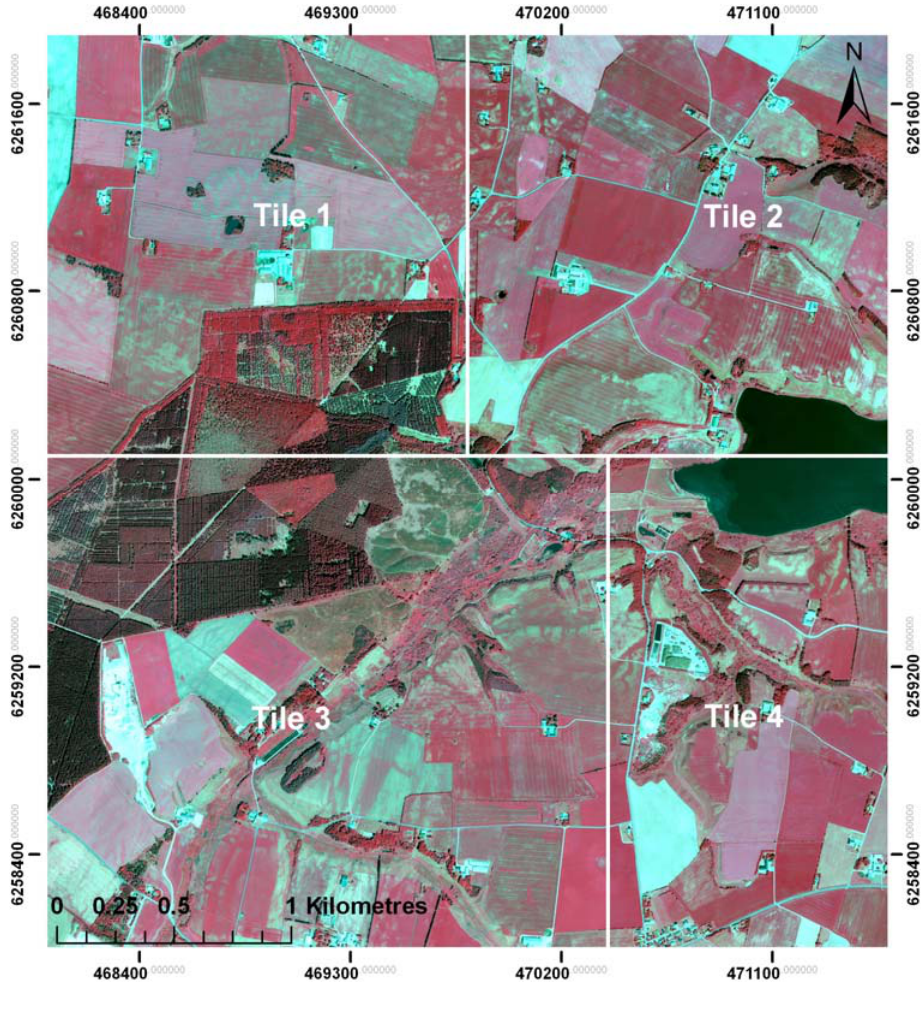
Figure 2. The study area divided into subareas